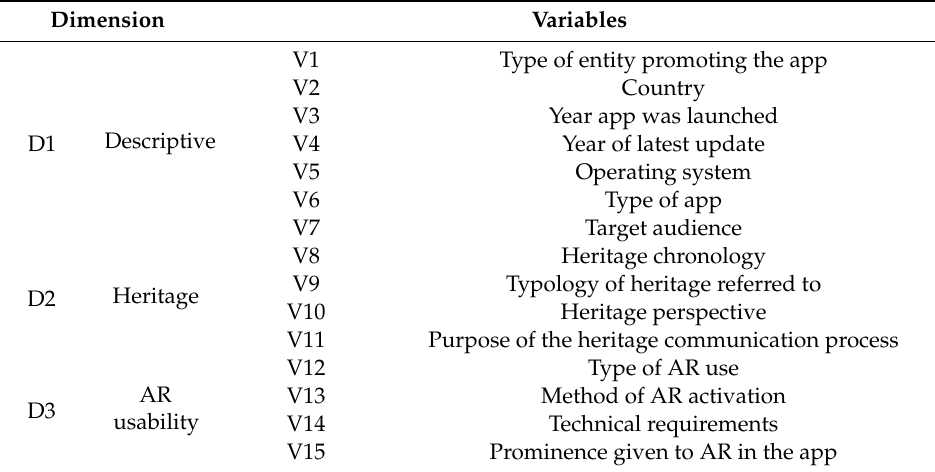
Table 3. Study object: dimensions and